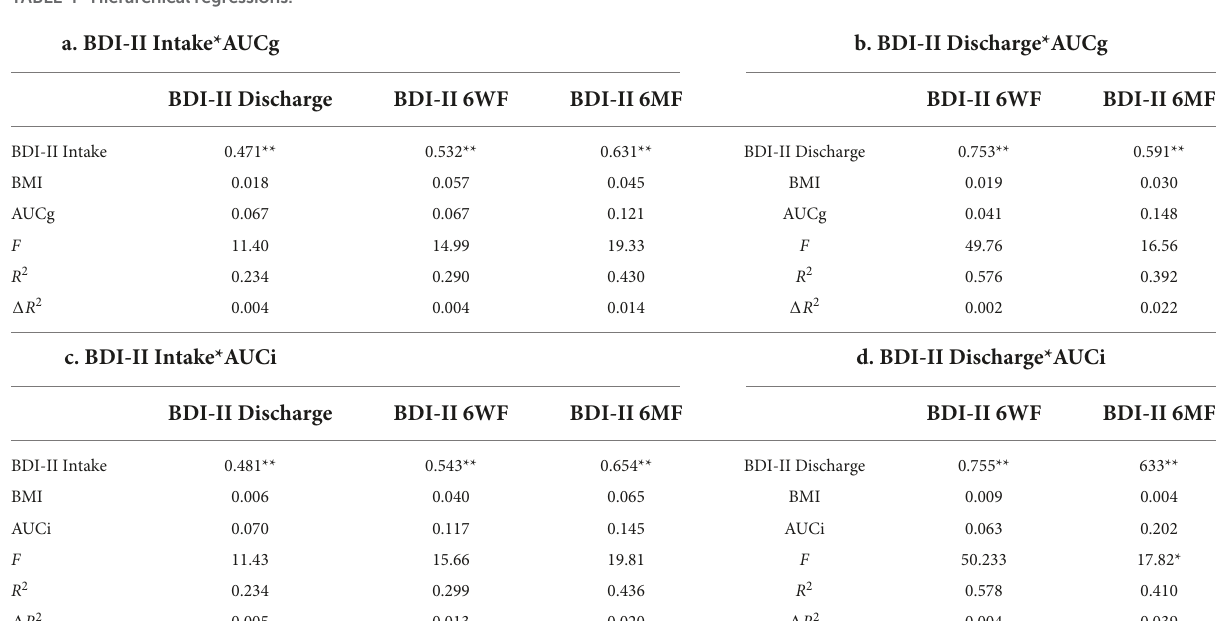
TABLE 4 Hierarchical